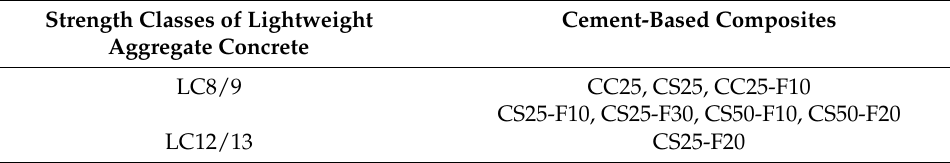
Table 4. Strength classes of the studied lightweight aggregate